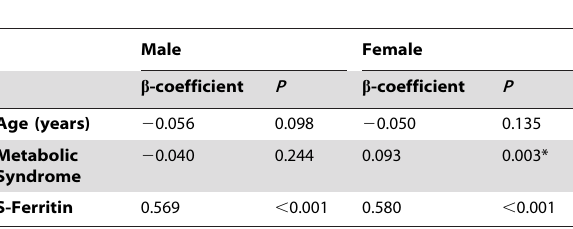
Table 3. Predictors of hepcidin-25 in males and females, considering MetS as a comprehensive binary (present versus absent)